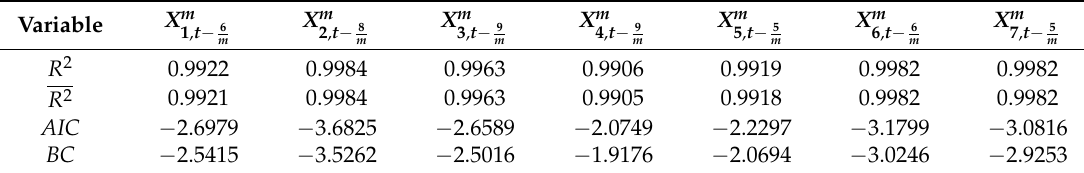
Table 3. Fitting Index Values of Mixing Regression Models with Different lag Orders. Variable